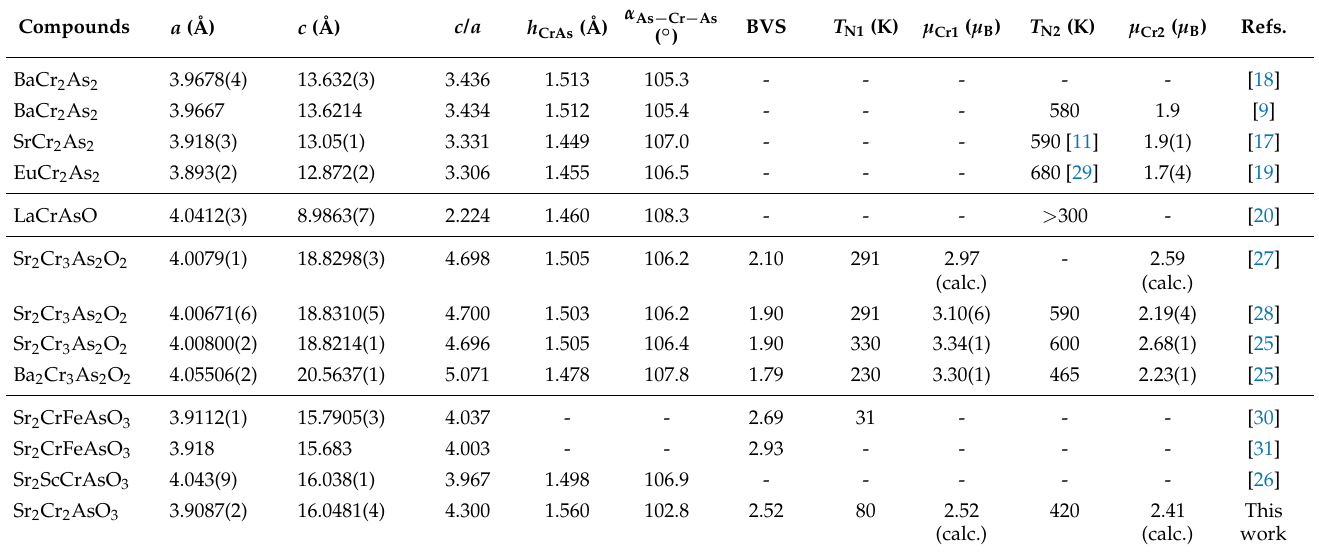
Table 1. Comparison of structural (at room temperature) and physical properties of the compounds with CrAs layers and/or CrO 2 planes. h CrAs denotes the As height from the Cr plane. α As − Cr − As is the As-Cr-As bond angle along a or b direction. BVS is the bond valence sum of Cr(1) coordinated by five oxygen atoms. T N1 and T N2 are the antiferromagnetic transition temperatures associated with Cr(1) and Cr(2), respectively, and µ Cr1 and µ Cr2 are their saturation magnetic moments. The symbol “-” represents that those data are not